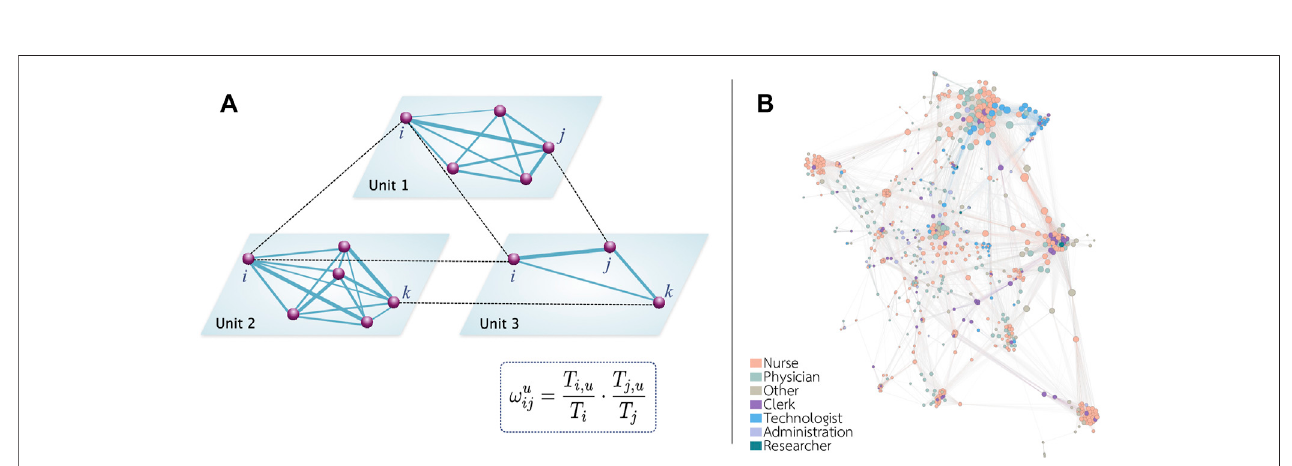
FIGURE 2 | Schematic representation of the network. (A) The spatial activities of each individual allow us to determine if two individuals could potentially interact. We assume that there is a link between two individuals if they visit the same unit. The weight of each link depends on the time proportion spent by each individual in that unit. (B) Representation of the network obtained in hospital B. To facilitate the visualization, only links with a weight larger than 0.1 are shown.